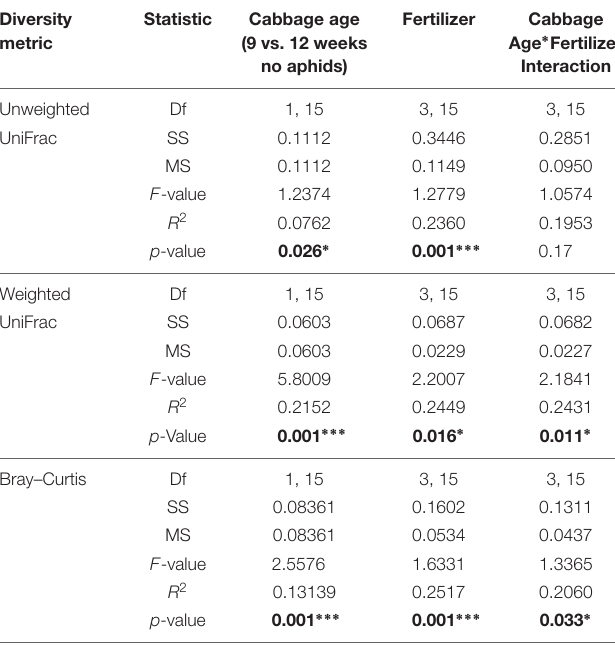
TABLE 3 | Results of permutational multivariate analysis of variance (PERMANOVA) analysis of dissimilarities for bacterial OTU community structure in relation to cabbage age, fertilizer treatment, and their interaction using UniFrac and Bray–Curtis distances.